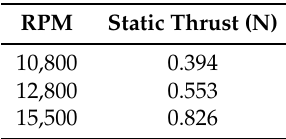
Table 5. Propeller static thrust with AP05